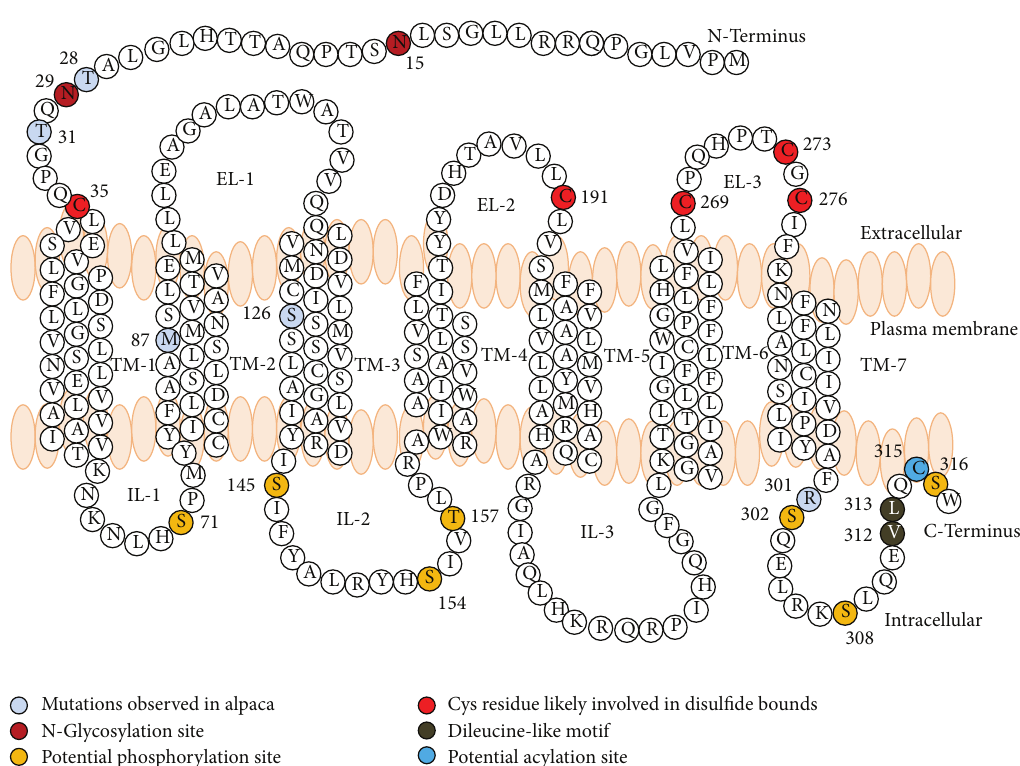
Figure 3: Structure of the alpaca MC1R. N-Terminus, extracellular loops (Els), intracellular loops (ILs), transmembrane (TM) regions, and the cytosolic C-terminal extension are labelled. The potential posttranslational modification sites and mutations reported in alpaca are also highlighted.